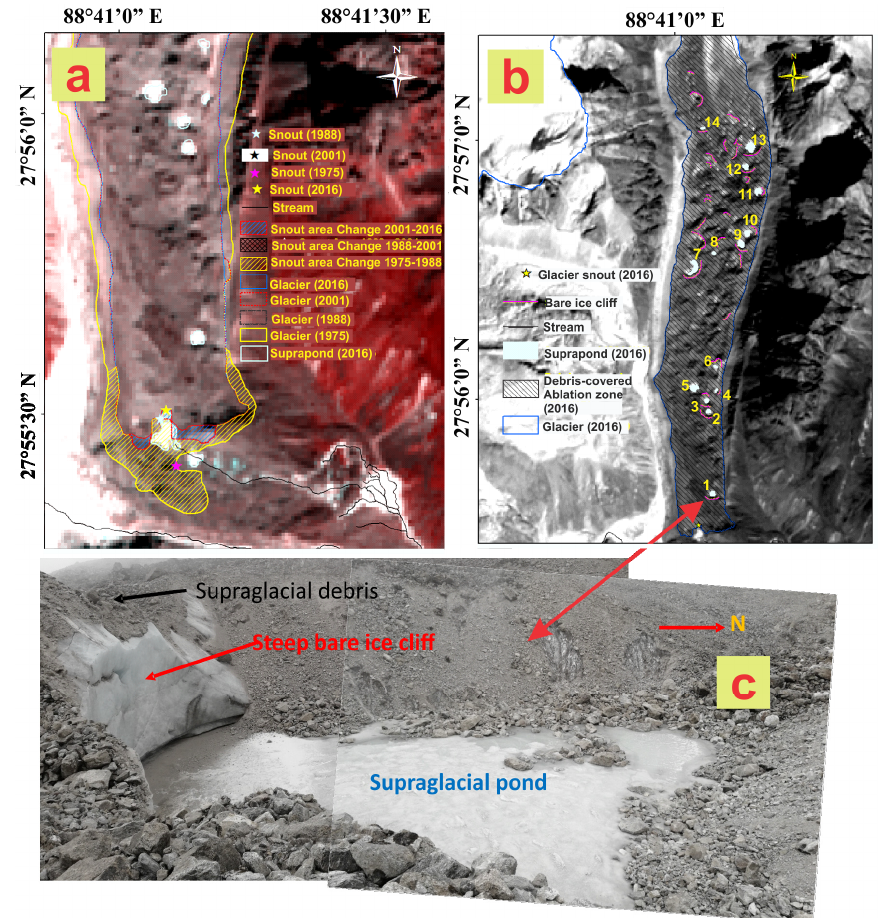
Figure 14. ( a ) Snout position and snout area changes of the CK glacier since 1975 to 2016. Base map: Sentinel 2A; ( b ) supraglacial ponds on the debris-covered ablation zone of CK glacier; ( c ) southernmost (No. 1) supraglacial pond (1410 m 2 area) covered by debris.